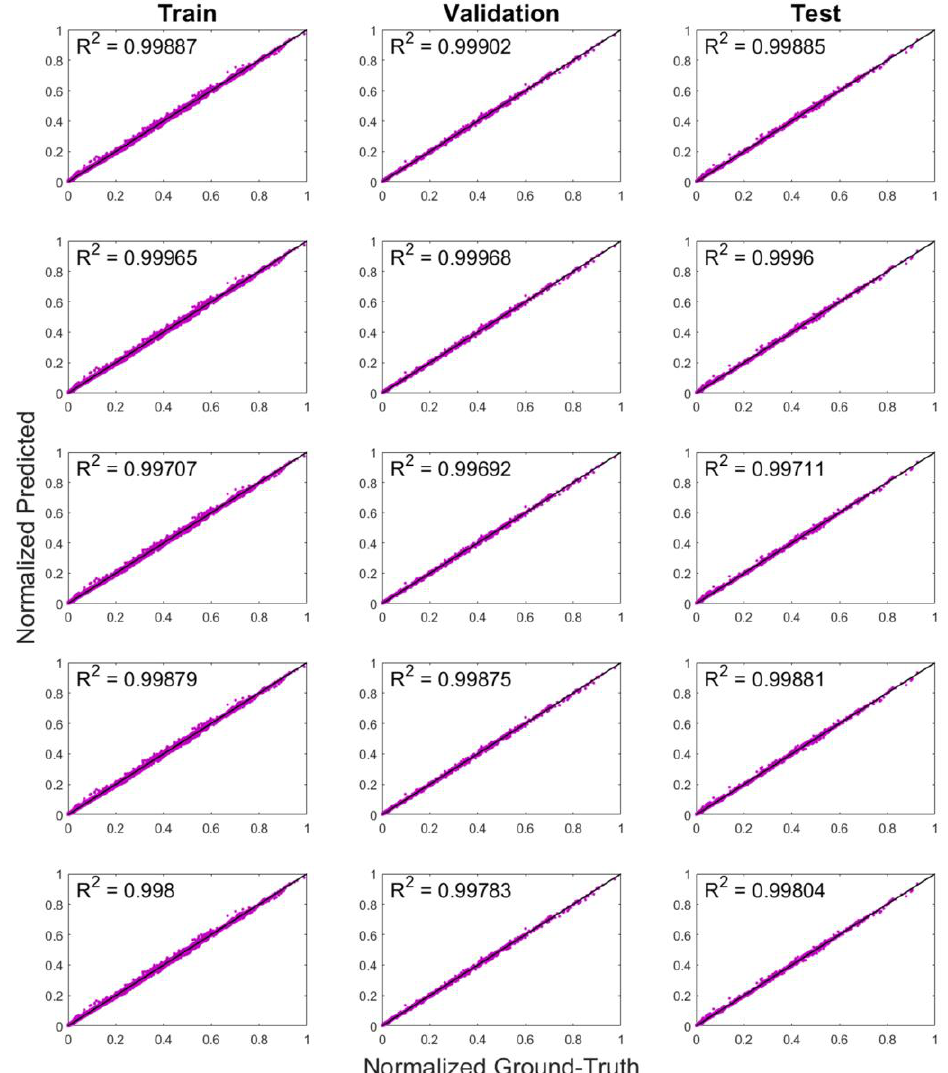
Figure 8. Parity plots show the performance of the ANN model, which compares the prediction results with the ground-truth (simulation) results. The first row of plots corresponds to structural residual trapping, the second row to residual trapping, the third row to residual trapping in the plume, the fourth to structural trapping in the plume, and the last row to the free plume. Table 4. The statistical indicator shows the performance of the ANN model. Indicator